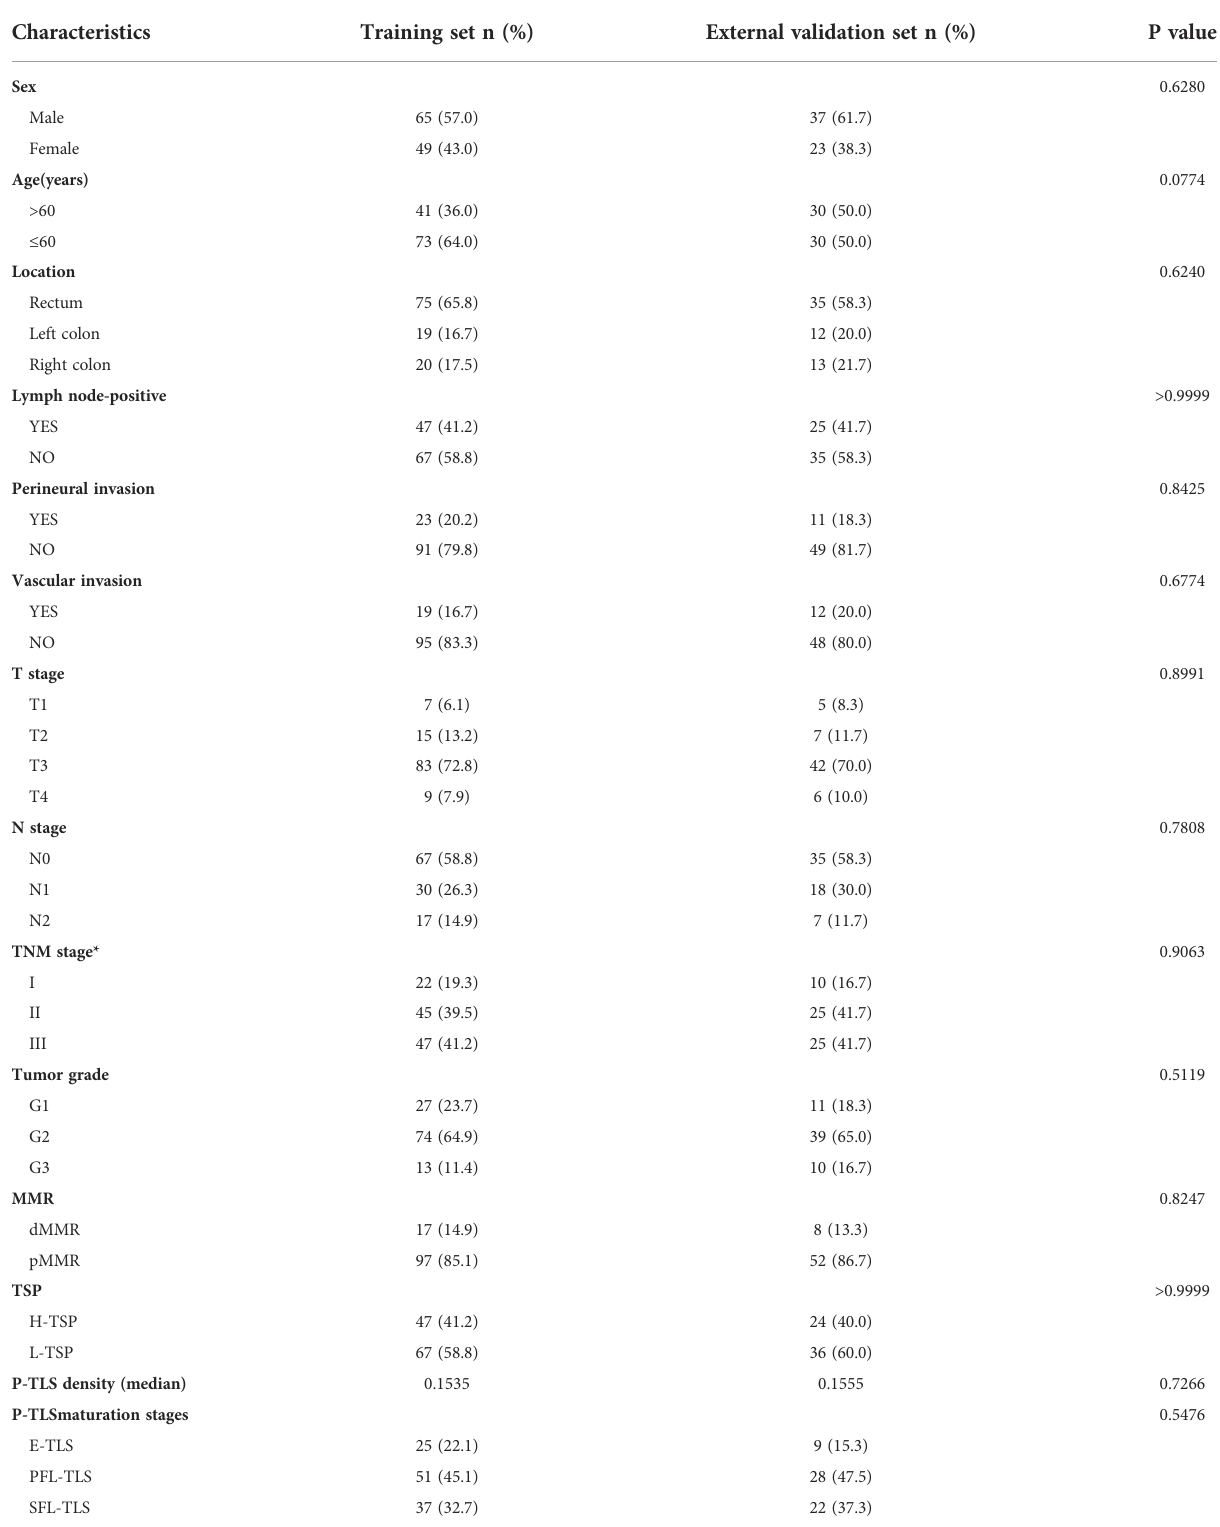
TABLE 1 Demographics and clinical characteristics of nmCRC